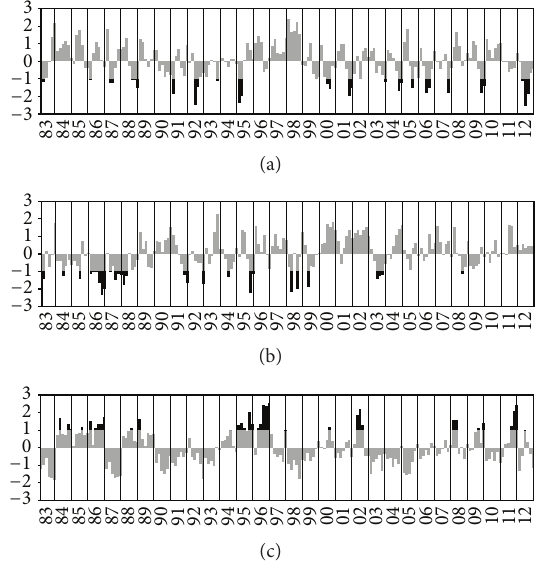
Figure 3: Time series of the PC coefficients associated with (a) EOF1 February, (b) EOF2 March, and (c) EOF1 April. The PCs in black with threshold below − 1 standard deviation for February and March and above +1 standard deviation for April represent ITCZ events selected for each